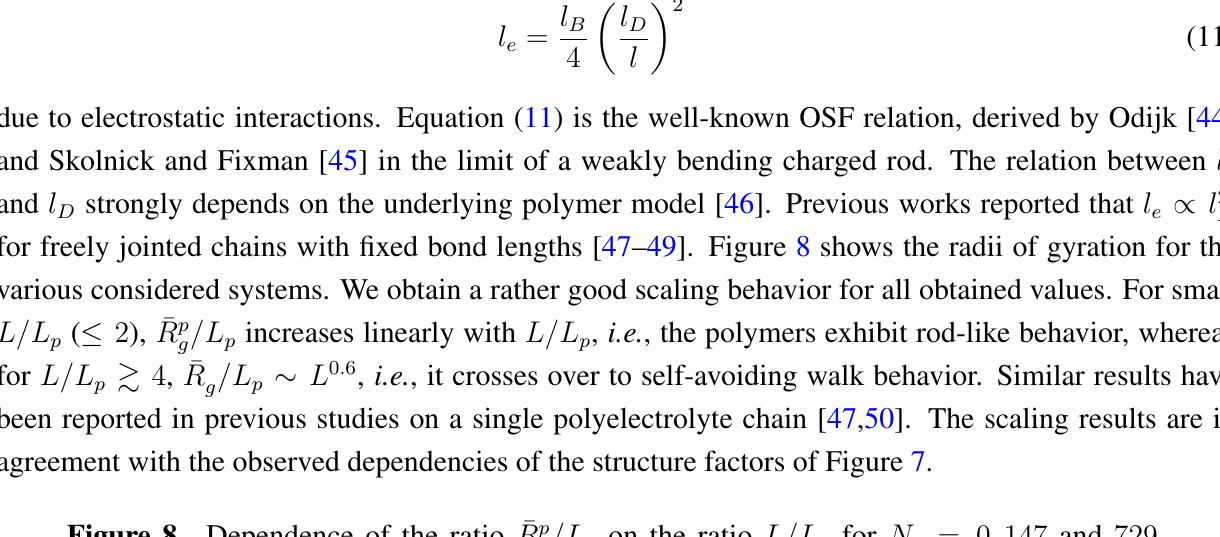
Figure 8. Dependence of the ratio ¯ R p N = 20 and 40 and l p red line to L/L